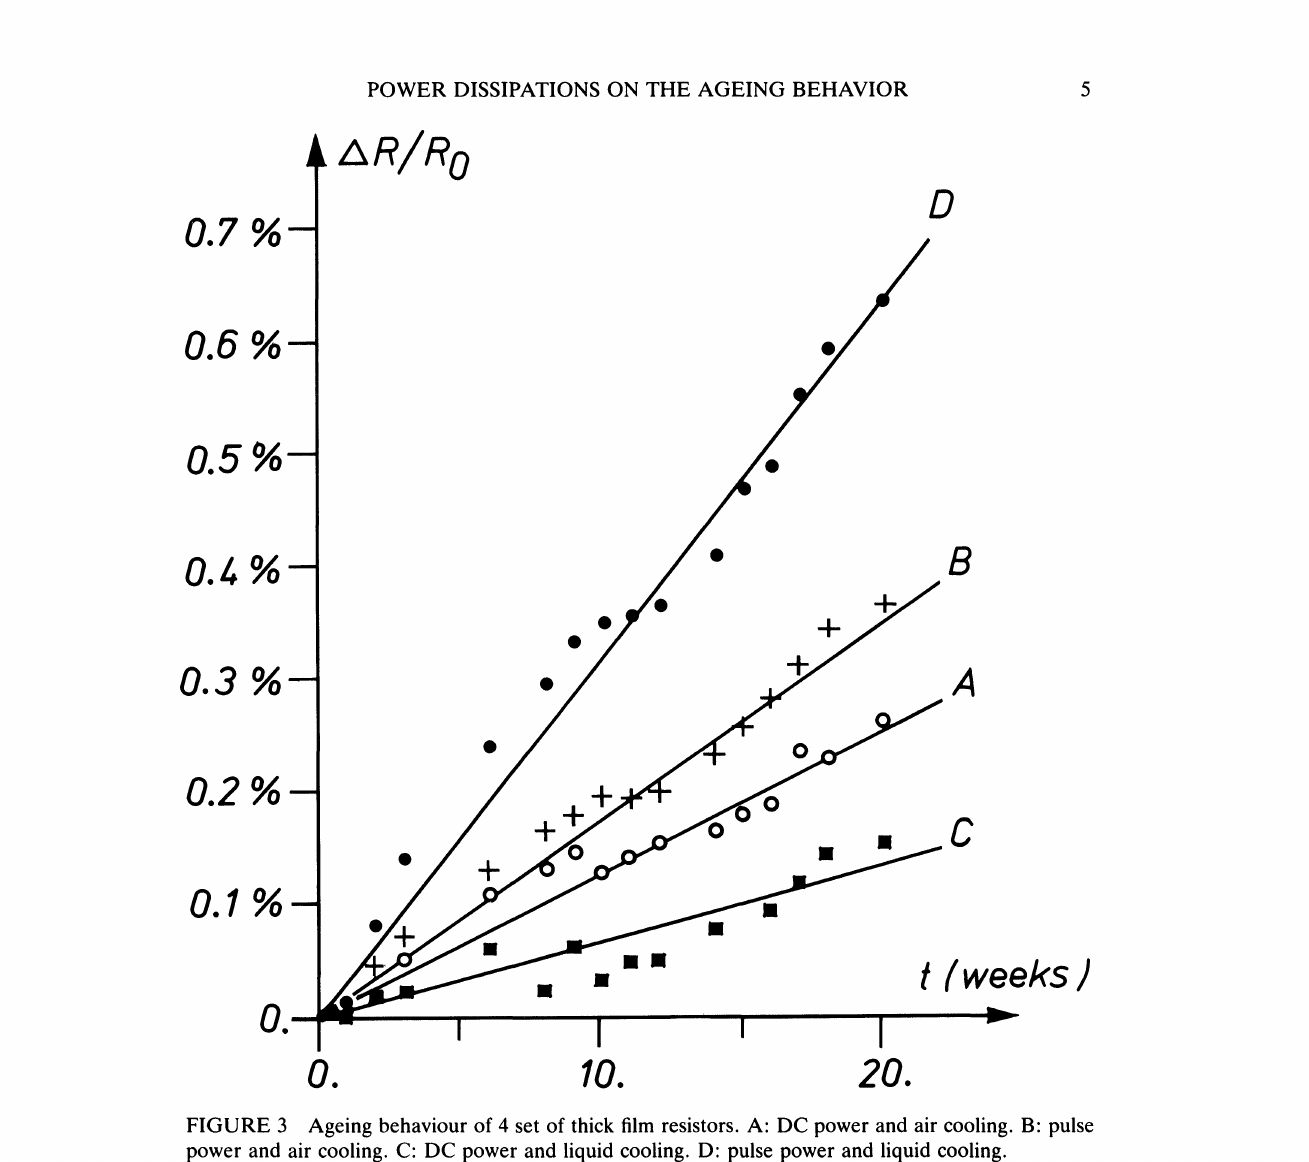
FIGURE 3 Ageing behaviour of 4 set of thick film resistors. A: DC power and air cooling. B: pulse power and air cooling. C: DC power and liquid cooling. D" pulse power and liquid